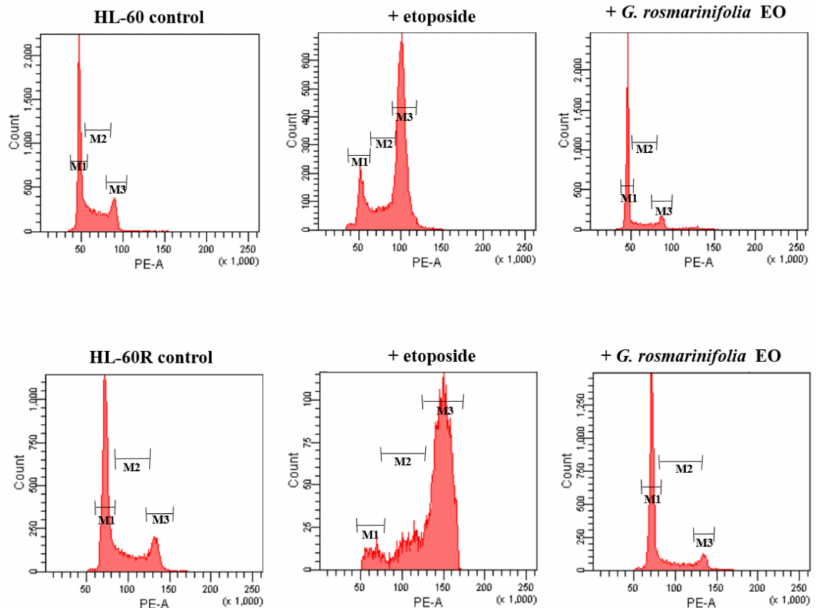
Figure 4. Cell-cycle analysis in the HL-60 and HL-60R cell lines. Cells were treated for 48 h with IC 50 of G. rosmarinifolia essential oil or etoposide. EO induced cell-cycle arrest in the G 0 -G 1 phase of the cell cycle, with a reduction in cells in the S-phase. The panel shows a representative experiment of three independent